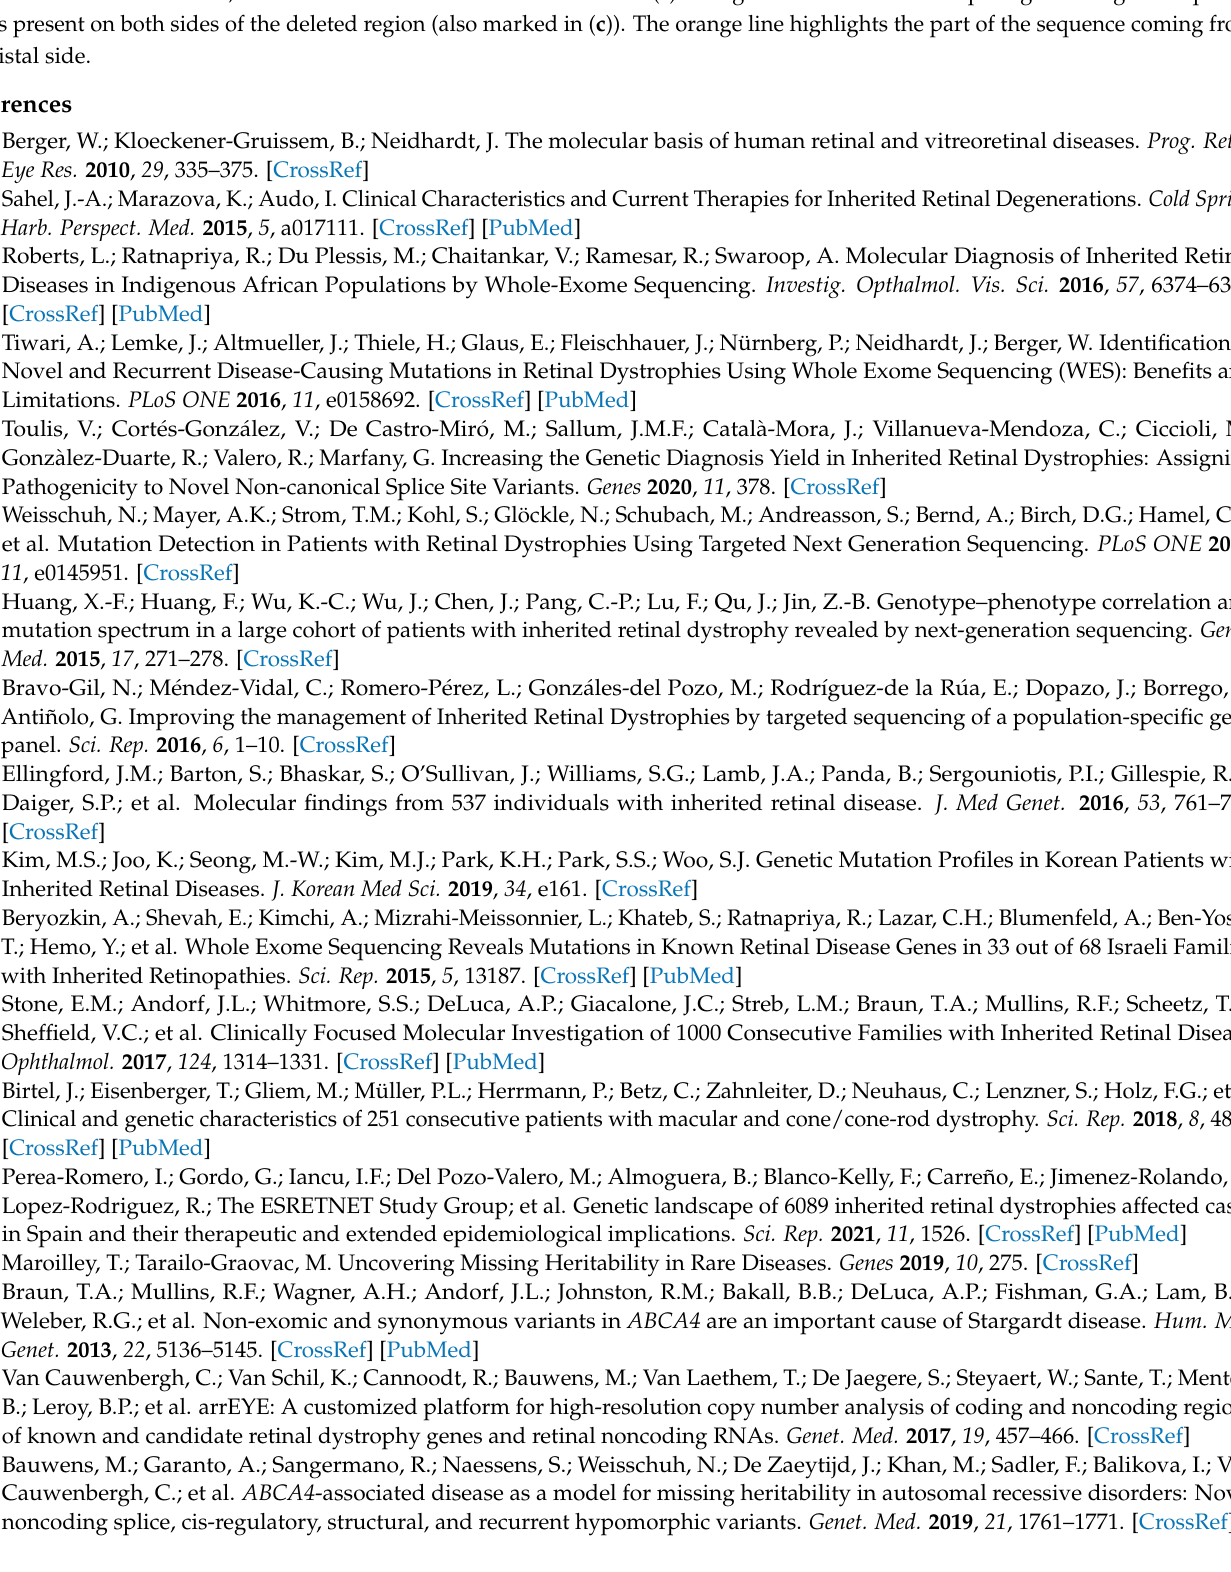
region in ( a ). ( c ) Magnification of the 5 (cid:48) (left) and 3 (cid:48) (right) breakpoint regions. The corresponding sequence is reported underneath the alignment figure. The blue line under the sequence shows the part of the junction region that originates from the proximal side of the deletion. The green line highlights the 4 bp-long homologous sequence that is present on both sides of the deleted region. The orange line marks the part of the sequence coming from the distal side. ( d ) Electropherogram of the Sanger sequencing results of the junction fragment for the index patient. The blue line above the sequence shows the part of the junction region that originates from the proximal side of the deletion, which can also be seen in the NGS results ( c ). The green line shows the 4 bp-long homologous sequence that is present on both sides of the deleted region (also marked in ( c )). The orange line highlights the part of the sequence coming from the distal